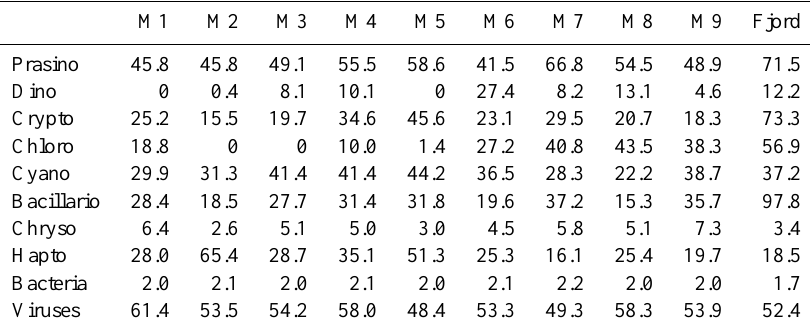
Table 2. Concentrations of chlorophyll a equivalent (in ngL − 1 ) for eight taxonomic groups of phytoplankton determined from HPLC mea- for details on methodologies. Abbreviations for taxonomic groups refer to prasinophyceae, dinophyceae, crytophyceae, chlorophyceae, cyanophyceae, bacillariophyceae, chrysophyceae, and